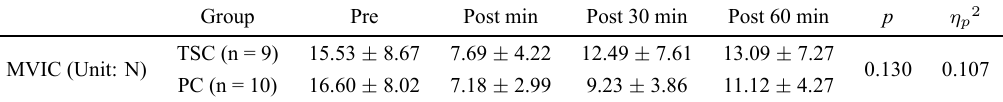
Table 2. Changes in maximum voluntary isometric contraction (MVIC) after topical sports cream. Group